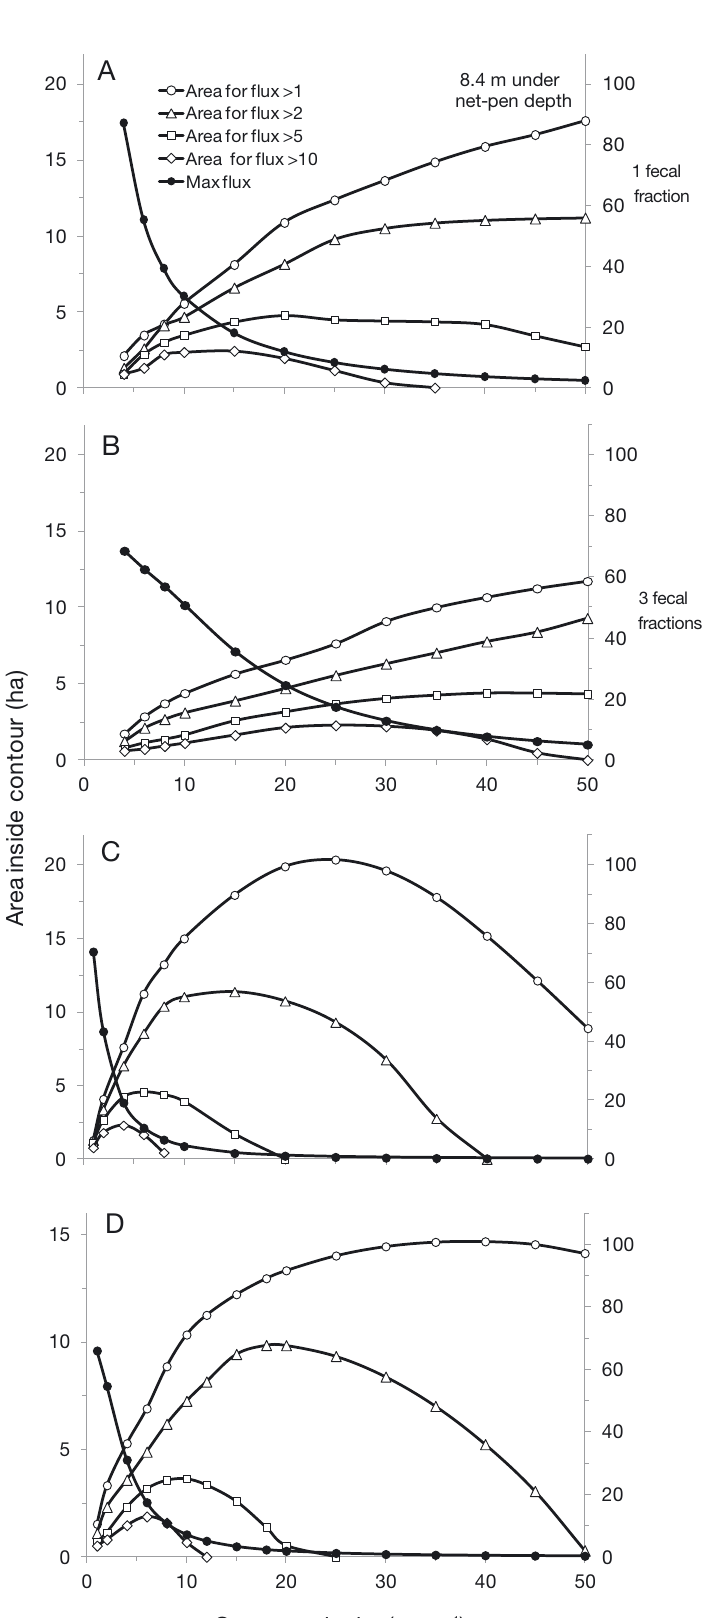
Fig. 4. Model output for maximum total POC waste sedimentation for Farm A in Bliss Har- bour integrated for the area under the net- pen array and various sedimentation rate contour areas with changes in current speed, under net-pen depth and number of fecal size fractions. Allowable production limit: 330000, mortality: 15% with no corrections for resuspension, decomposition or waste feed consumption in all comparisons. (A) 1 fecal size fraction, settling speed (w) 3.2 cm s −1 and (B) 3 fecal size fractions (0.66, 0.25 and 0.09; w = 7.5, 3.0 and 0.5 cm s −1 ) with 8.4